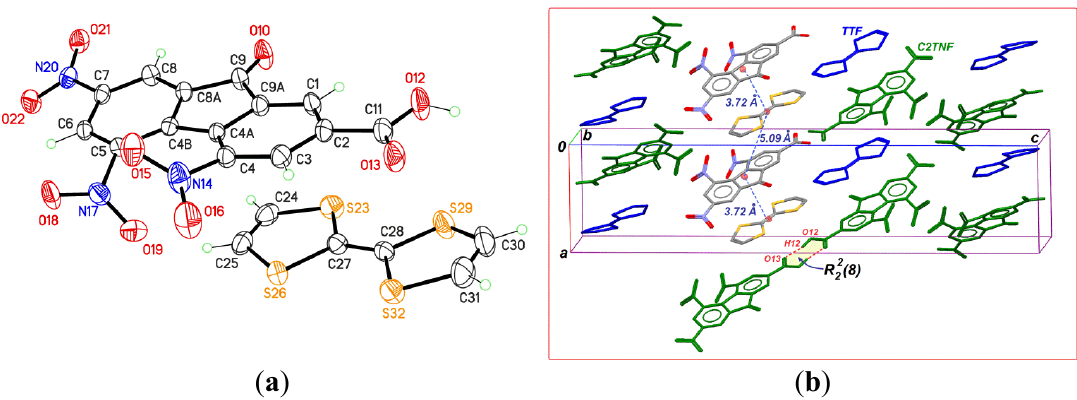
Figure 1. ( a ) ORTEP -like view of the asymmetric unit in 1 , with 30% displacement ellipsoids for non-H atoms; ( b ) Part of the packing structure of 1 , showing separations between TTF and C2TNF in one stack. The R 2 (8) motif connects two C2TNF molecules in 2 two neighboring stacks. All H atoms have been omitted, except hydroxyl H atoms (H12) involved in the R motif.